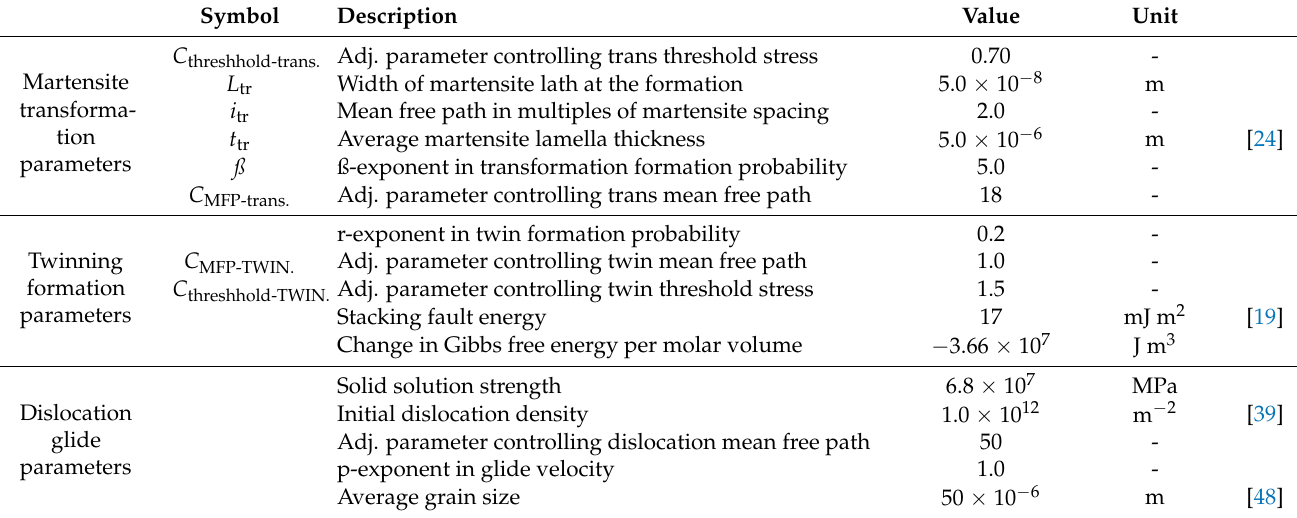
Table 2. Optimized constitutive model parameters for X3CrMnNi16-7-6 TRIP steel.